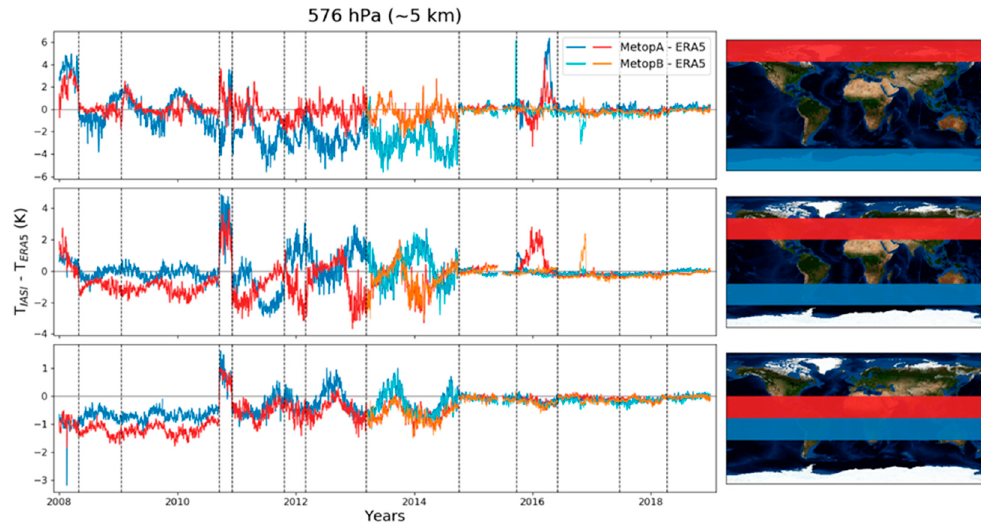
Figure 5. Differences between the IASI and ERA5 temperature at 576 hPa for Metop-A and Metop-B at the poles, mid latitudes, and equator. Note that the y-axis limit is different for the different latitude bands. The vertical dashed lines correspond to L2 updates.